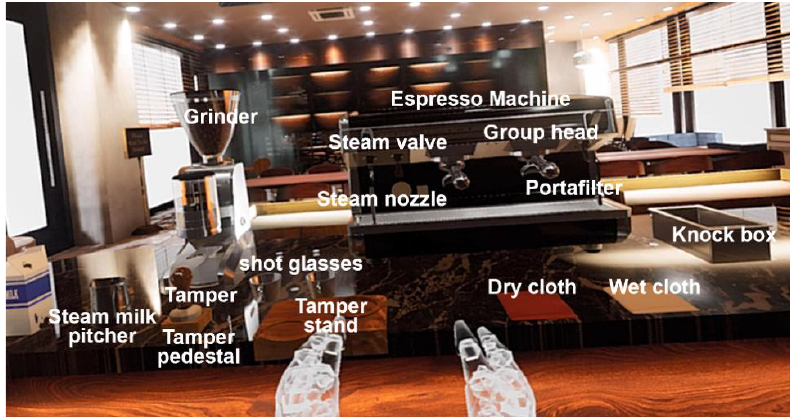
Figure 3. Barista objects in virtual reality-based barista training contents.